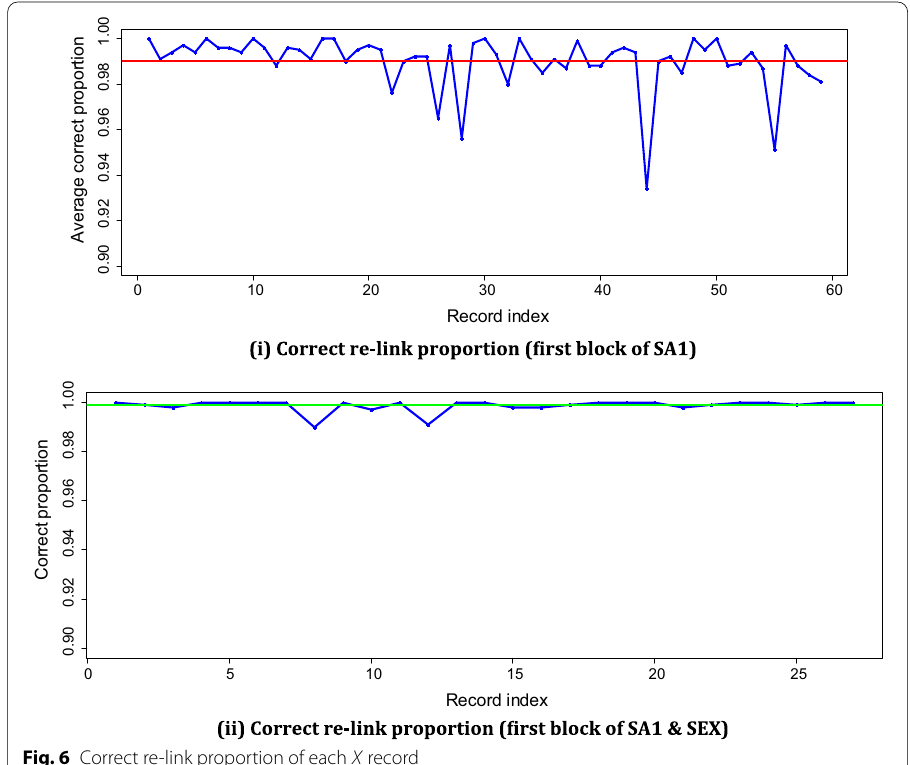
Fig. 6 Correct re-link proportion of each X